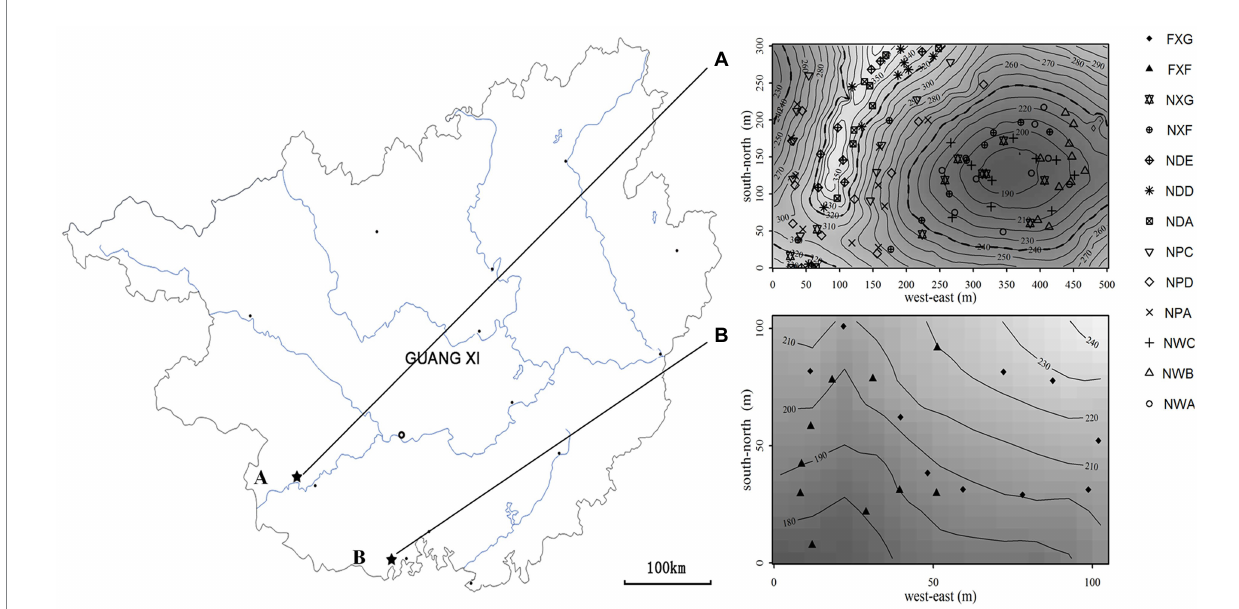
FIGURE 1 Locations of the sampling sites in two plots in Guangxi province (R software (version 3.3.0) was employed to produce Maps). A: Nonggang northern tropical karst seasonal rainforest dynamics plot; (A) : sampling points of the Nonggang plot. B: Fangcheng northern tropical seasonal rainforest dynamics plot; (B) : sampling points of the Fangcheng